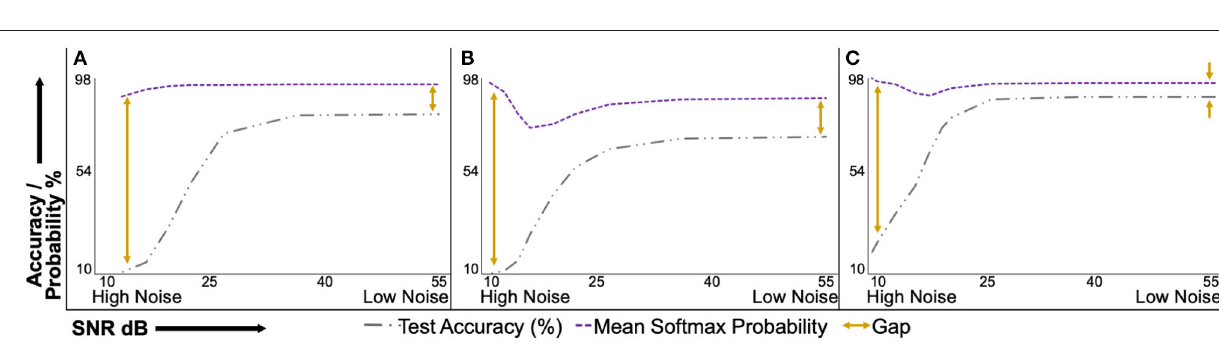
FIGURE 5 | Uncalibrated mean softmax probability and corresponding test accuracy of deterministic models under varying signal-to-noise ratio (SNR). The plots are conveniently interpreted if read from right to left on the horizontal axis. The mean softmax probability is higher than the model accuracy at the minimum tested noise level (right side of the horizontal axis). As the noise level increases, the accuracy-probability gap continues to widen. This behavior shows the overconfidence of deterministic models, especially at higher noise levels. (A) , PathMNIST; (B) , DermaMNIST; and (C) , OrganAMNIST.